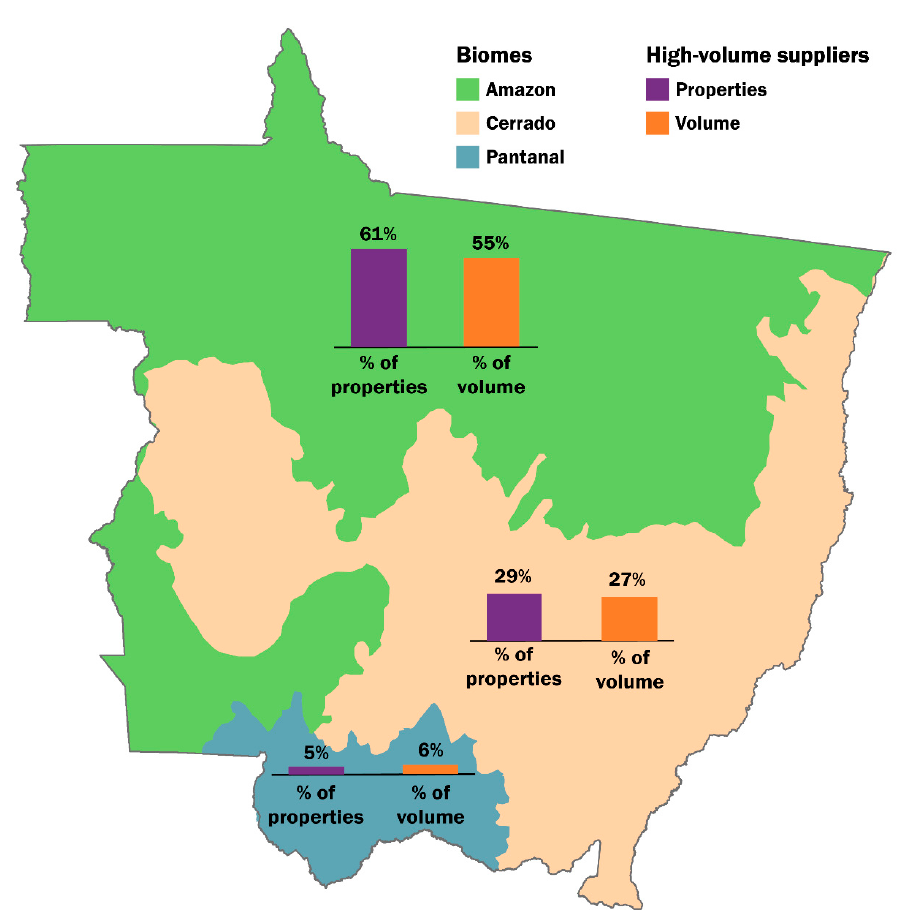
Figure 3. Distribution of high-volume suppliers and their suppliers and buyers across the three different biomes of Mato Grosso State in percent of number of total properties and area.